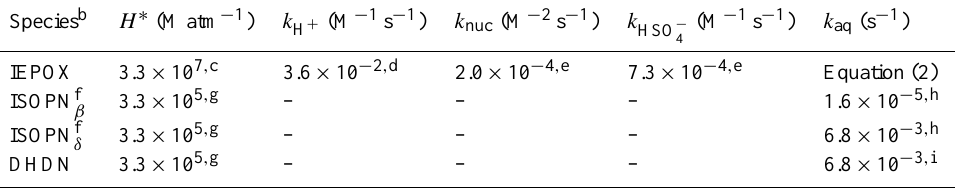
Table 1. Constants for reactive uptake of isoprene SOA precursors a .